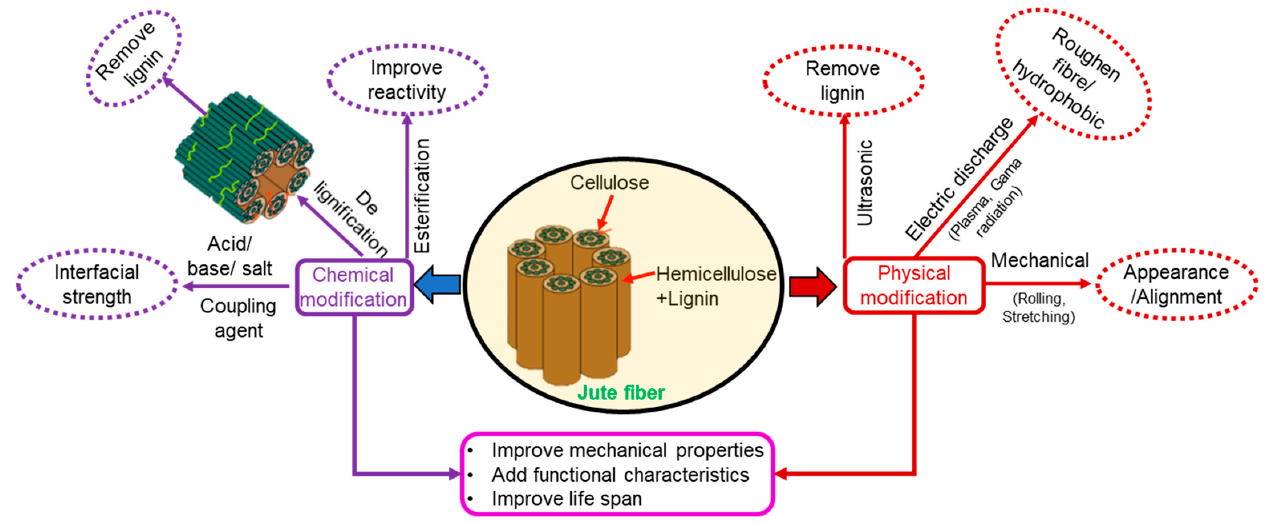
Figure 1. Overview of treatments on the jute fiber for polymer composite fabrication.